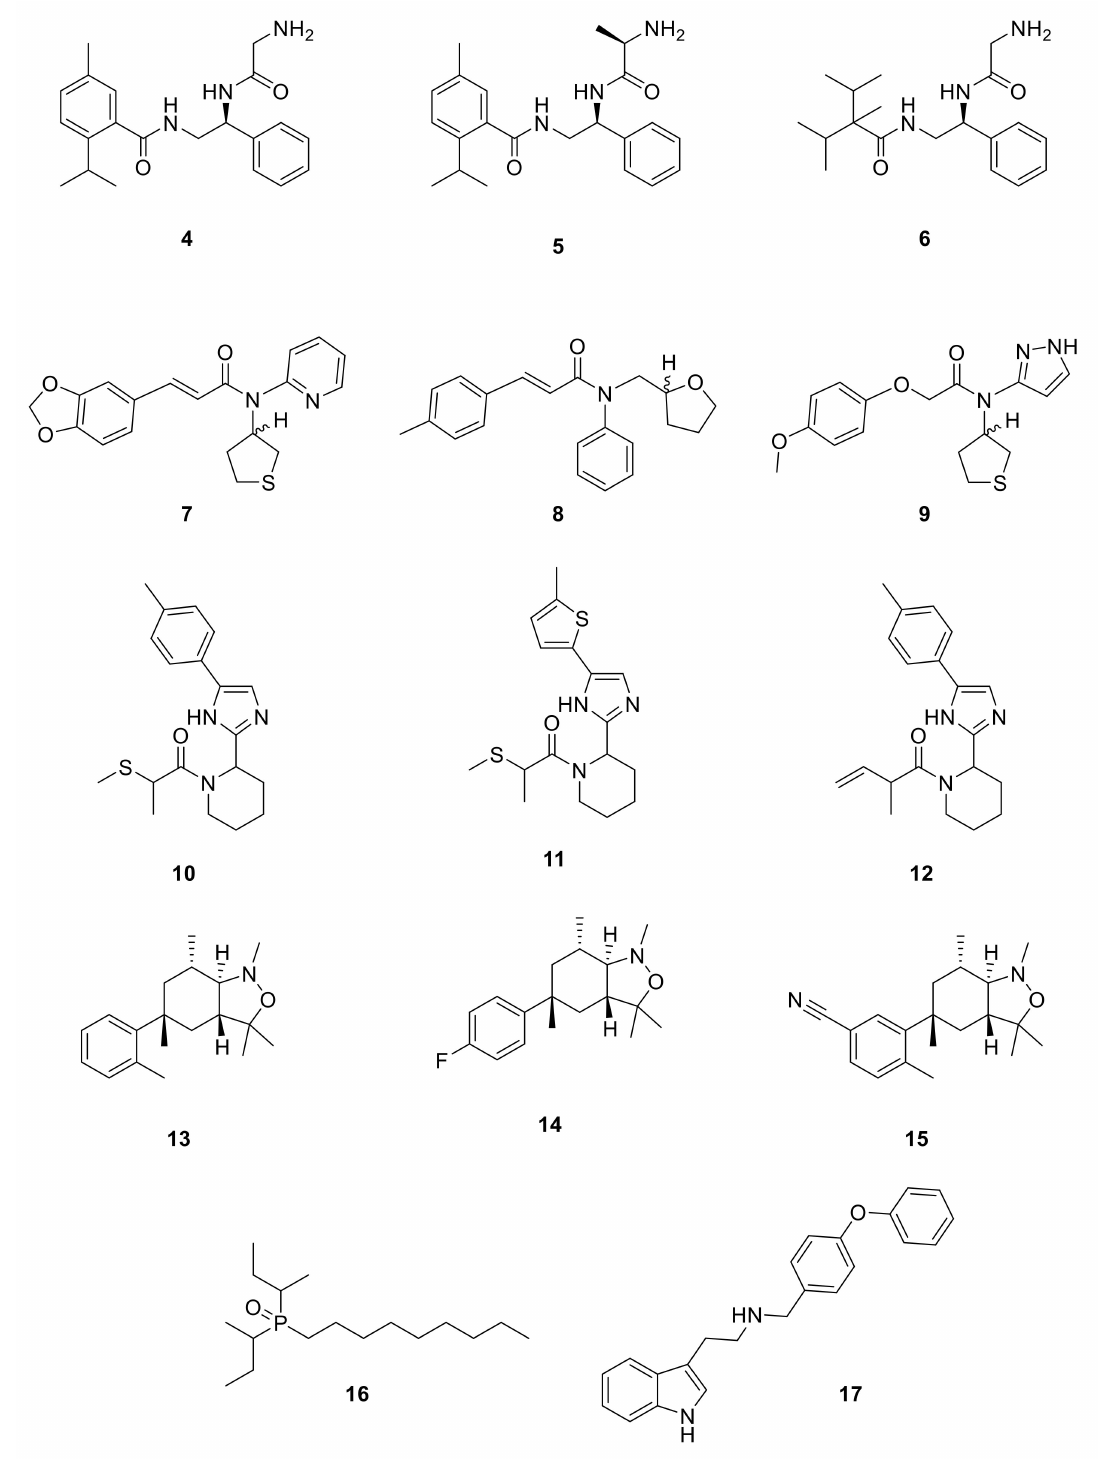
Figure 4. Main TRPM8 agonists: selected compounds from new chemotypes recently described. Procter and Gamble Company directed efforts to find molecules with alternative moi- eties to the menthol-like cyclohexane fragment [127]. In this patent, they presented a series of derivatives able to activate TRPM8 with EC 50 values suitable for their use as coolant compounds (EC 50 ≤ 1 µ M). It was also claimed that they can promote thermogenesis, favoring the formation of beige and/or brown adipocytes over white ones and, therefore, of possible application in the treatment of obesity. The biological evaluation showed